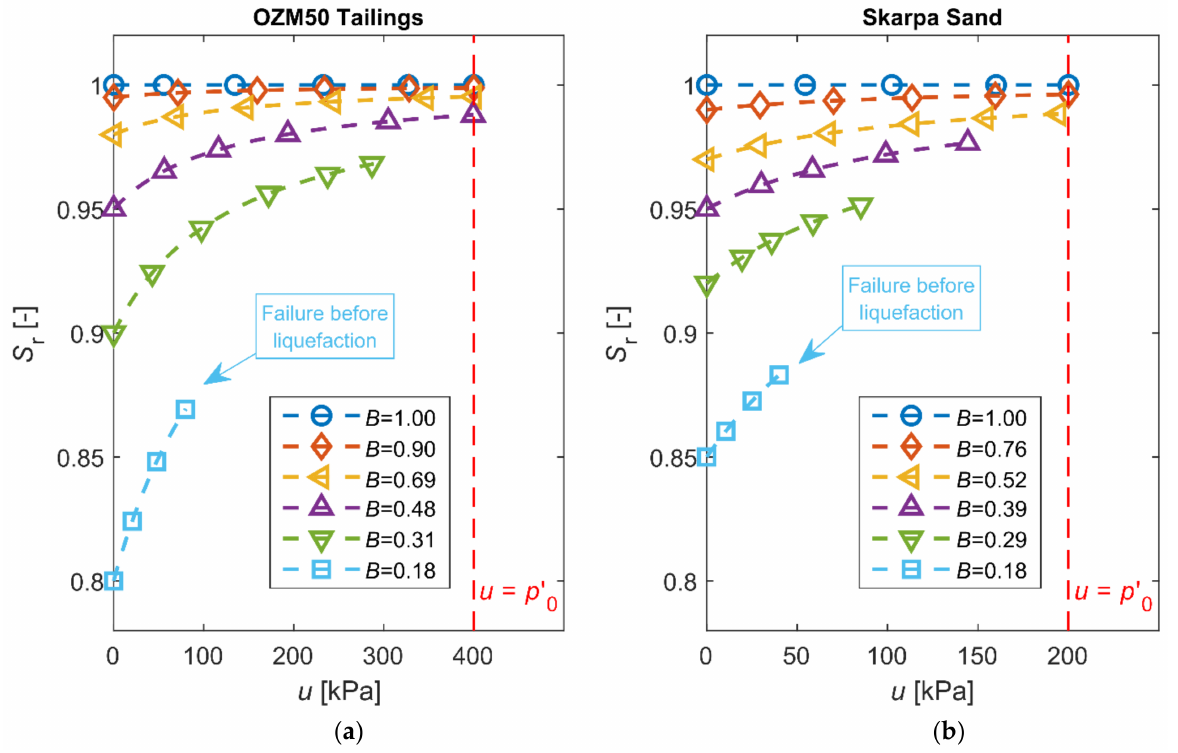
Figure 20. Model prediction of changes in degree of saturation during shearing presented in: ( a ) Figure 18 and ( b ) Figure 19.